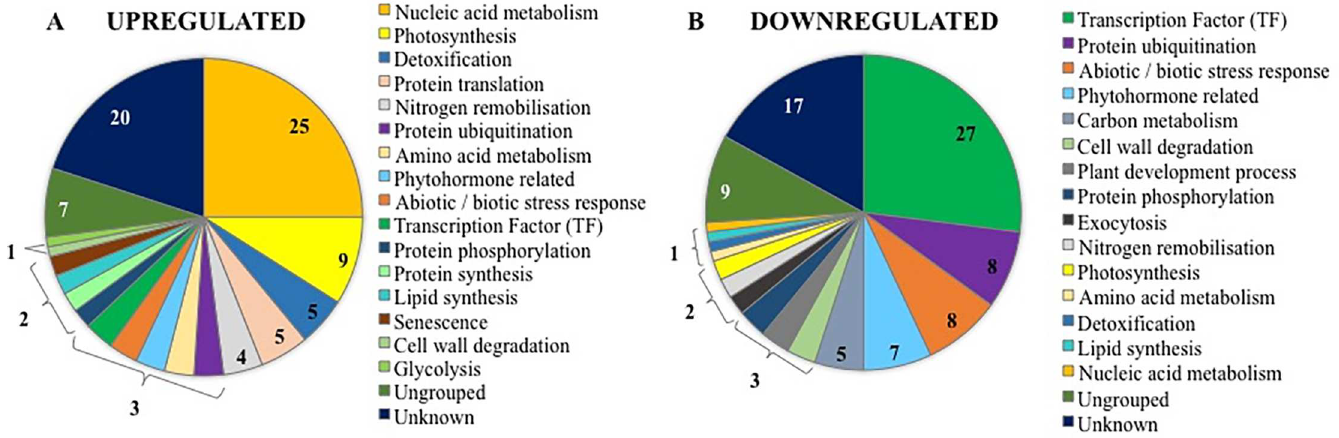
Fig 2. The 100 most highly upregulated (A) and downregulated (B) genes in T8. The number in the chart indicates the number of genes that are assigned in the